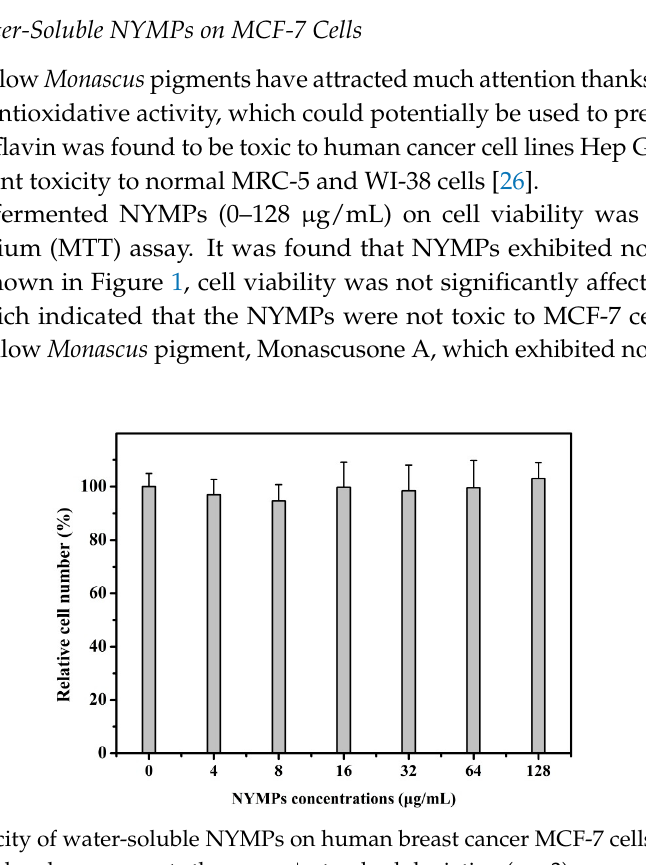
Figure 2. Effects of water-soluble NYMPs on cell proliferation of human breast cancer MCF-7 cells. Cells were incubated with NYMPs for 24 and 48 h. NYMPs 4, NYMPs 8, NYMPs 16, and NYMPs 32 represents 4, 8, 16, and 32 μ g/mL, respectively. Each value represents the mean ± standard deviation ( n = 3). * p < 0.05, ** p < 0.01 and *** p < 0.001 indicated statistically significant differences versus control group.